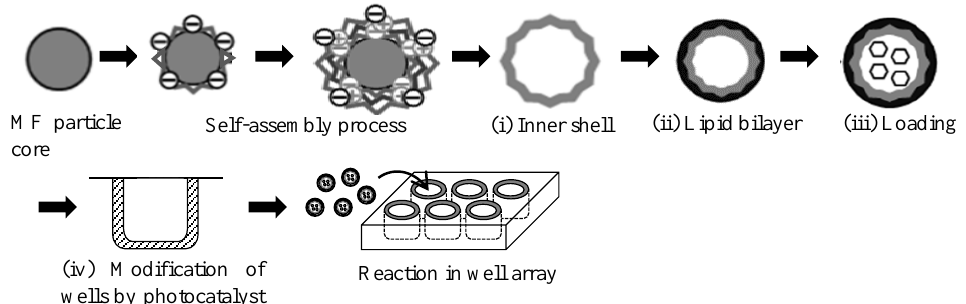
Reaction in well array (iv) Modification of wells by photocatalyst Figure 2. Schematic diagram of the preparation procedure for the two elements—the microcapsules and the well-array—needed for the microcapsule-based amplification method. MF—melamine-formaldehyde.